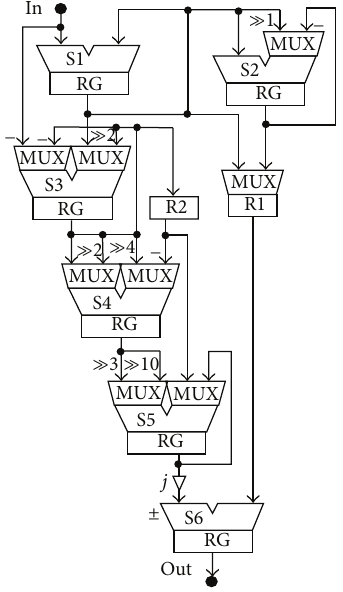
Figure 3: Structure of the DFT